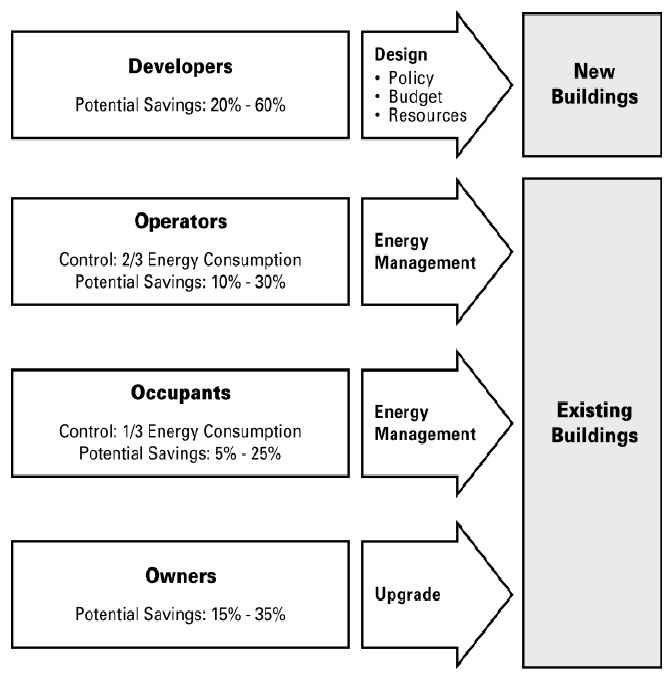
Figure 3. Key influences on building energy consumption